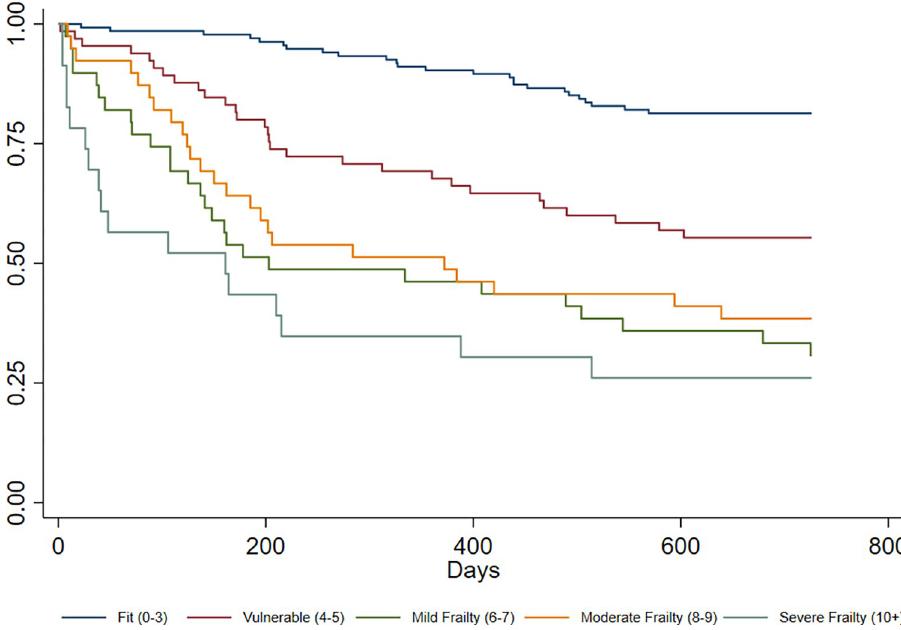
Fig 1. Kaplan-Meier survival curves for overall survival (days) according to conventional EFS categories.